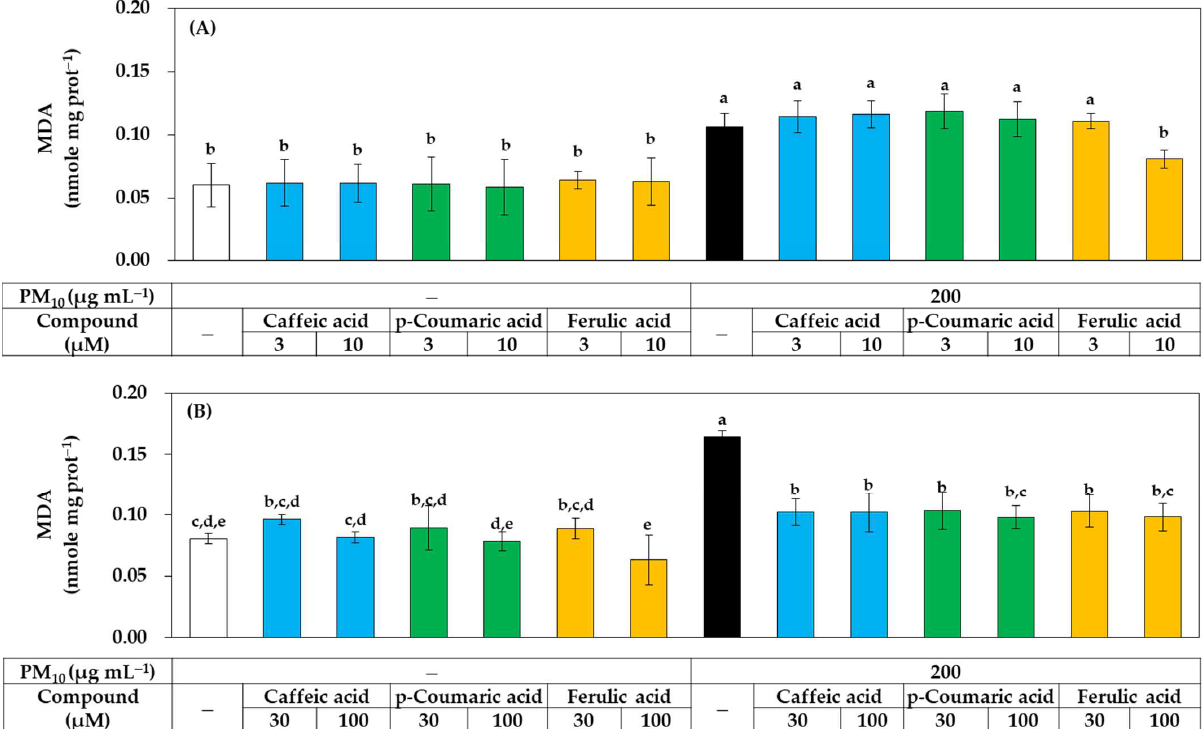
Figure 8. Effects of caffeic acid, p- coumaric acid, and ferulic acid on the lipid peroxidation in HaCaT keratinocytes exposed to PM 10 . Cells were treated with each compound at 3–10 μM ( A ) or 30–100 μM ( B ) alone or in combination with PM 10 (200 μg mL −1 ) for 48 h. Lipid peroxidation levels of cell lysates were determined by TBA assay and data are presented as MDA levels corrected for protein contents. Data are presented as mean ± SD ( n = 4). Duncan’s multiple range test was performed to compare all group means to each other. Groups that share the same letters (a–e) do not have significantly different means at the p < 0.05 level.